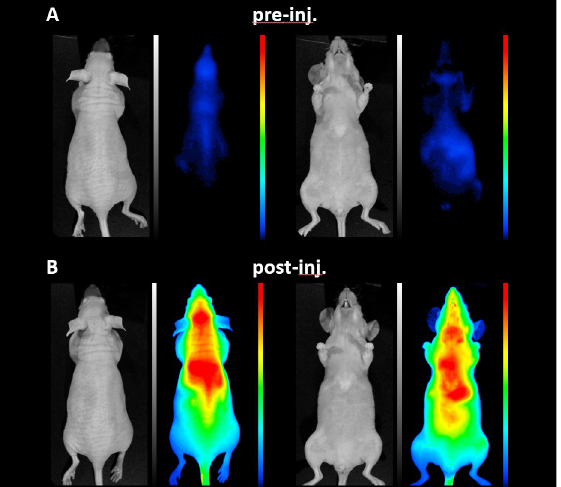
Fig 5. White and fluorescent images of a mouse (A) before and (B) after intravenous administration of Prussian Blue (images from left to right: prone white, prone fluorescent, supine white, supine fluorescent images) at 690 nm. After the PBNP administration enhanced dye concentration was registered in the head and thoracic region based on the high dye content of the circulation system, furthermore the images illustrated the liver of the animal. The images are highlighted on the same dynamic color look-up table, which illustrates the signal intensity with different tone from cold to hot colors.